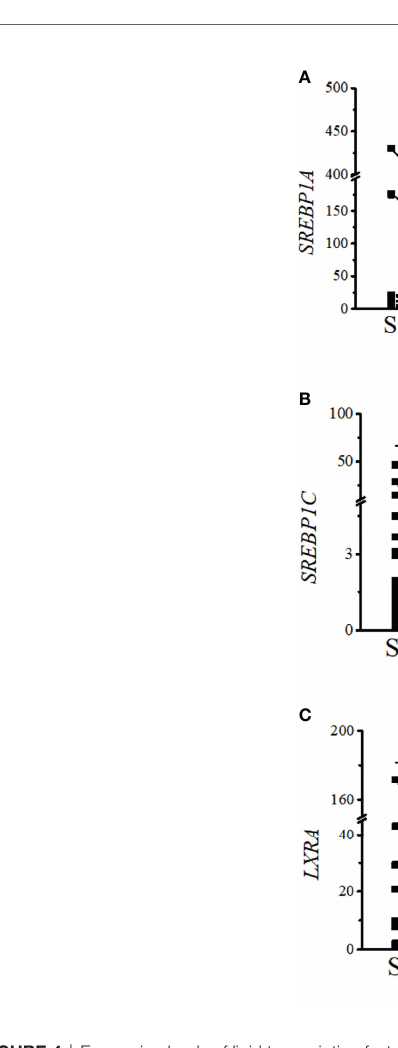
FIGURE 4 | Expression levels of lipid transcription factors related to in fl ammation decrease in the infrapatellar fat pads (IFP). Expression levels of SREBP1A (A) , SREBP1C (B) , and LXRA (C) in the IFP and subcutaneous fat tissues (SC) from osteoarthritis (OA) and rheumatoid arthritis (RA) patients. The panels to the left contain results comparing the expression levels between SC and IFP without division by diseases. The panels to the right contain results comparing the expression levels of SC and IFP in patients with OA, RA treated with bDMARDs, and RA without bDMARDs treatment. Lines connecting the dots from SC to IFP indicate samples from the same patients. The samples were labeled and separated into CD14-positive cells from the stromal vascular fraction of the IFP and SC from each patient. The median (interquartile range, IQR) expression levels of SREBP1A , SREBP1C , and LXRA in the SC from all patients were 0.31 (0 – 5.25), 0.98 (0.22 – 2.98), and 0.69 (0.34 – 2.12); these expression levels changed to 1.1 (0.09 – 4.81), 0.30 (0.16 – 0.71), and 0.039 (0.0085 – 0.50) in the IFP. The median (IQR) expression levels of SREBP1C and LXRA in the SC from OA patients were 1.03 (0.03 – 3.69) and 0.69 (0.34 – 2.14); these expression levels changed to 0.31 (0.23 – 0.71) and 0.039 (0.018 – 0.50) in the IFP. The median (IQR) expression levels of LXRA in the SC and IFP from RA patients who were not treated with bDMARDs were 1.04 (0.065 – 20.89) and 0.017 (0.0067 – 0.81). Signi fi cant differences are displayed in each fi gure. OA, n = 15; RA without bDMARDs, n = 7; RA with bDMARDs, n = 9, respectively. The 2 − DD CT method was used to quantify the qPCR data. GAPDH was used as the reference gene. The average GAPDH Ct values from all SC samples were used to normalize the Ct values. The Y-axes indicate the relative expression levels of mRNA, which were normalized by GAPDH . * p < 0.05, ** p < 0.01, and **** p < 0.0001, as determined using the Mann – Whitney U -test for differences between the IFP and SC groups and the paired-sample Wilcoxon signed-rank test for differences between IFP and SC within the OA, RA without bDMARDs, and RA with bDMARDs